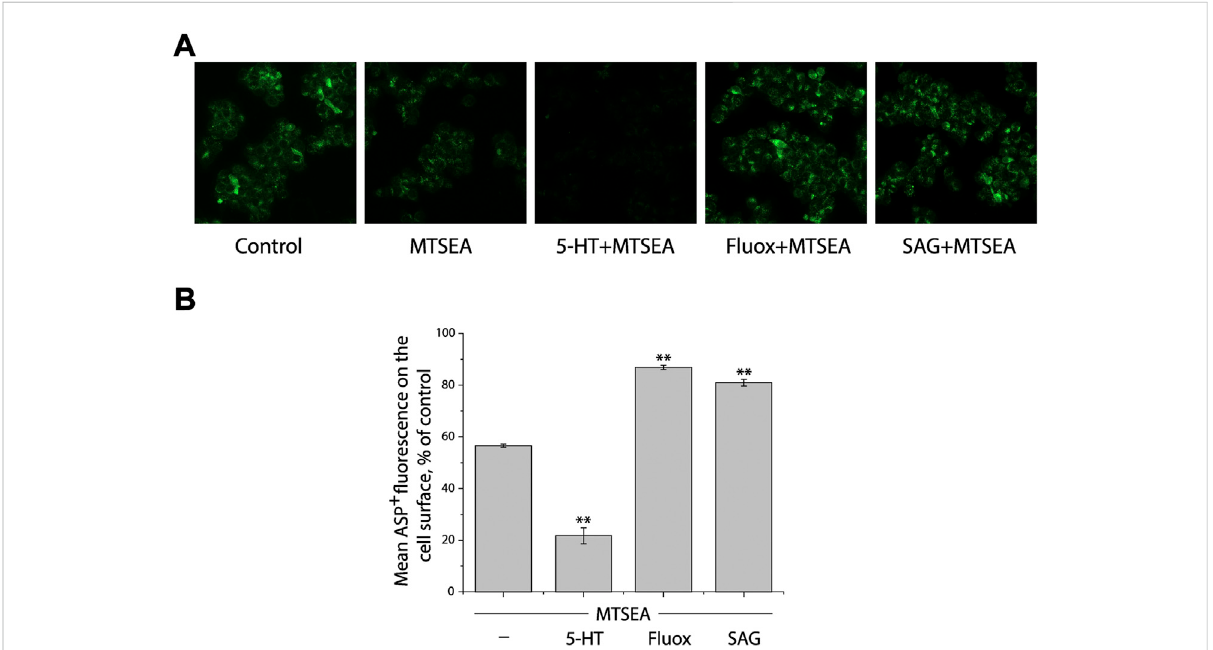
FIGURE 3 In fl uence of SAG on the cytoplasmic-facing conformation in SERT. (A) Representative images of ASP + binding on the cell membrane of SERT mutant, S277C/X5C, after treatment without (control) or with 0.2 mM MTSEA in the absence (MTSEA alone) or presence of 10 μ M 5-HT (5-HT